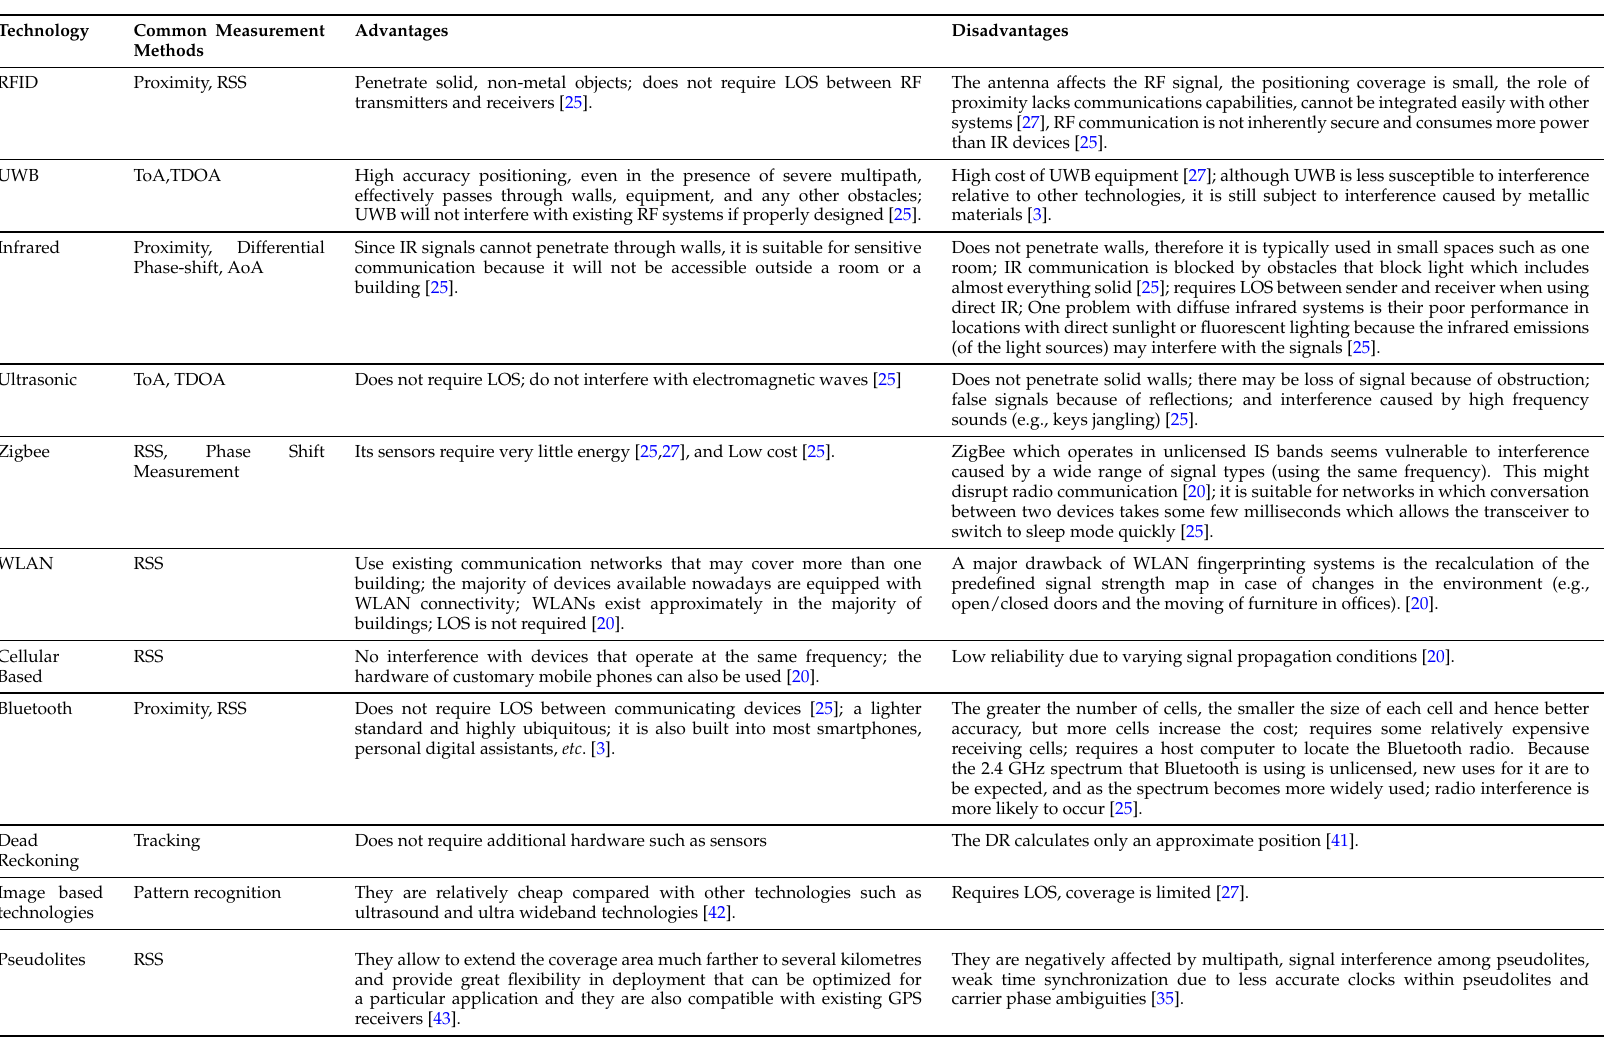
Table 5. Comparison between Indoor Positioning